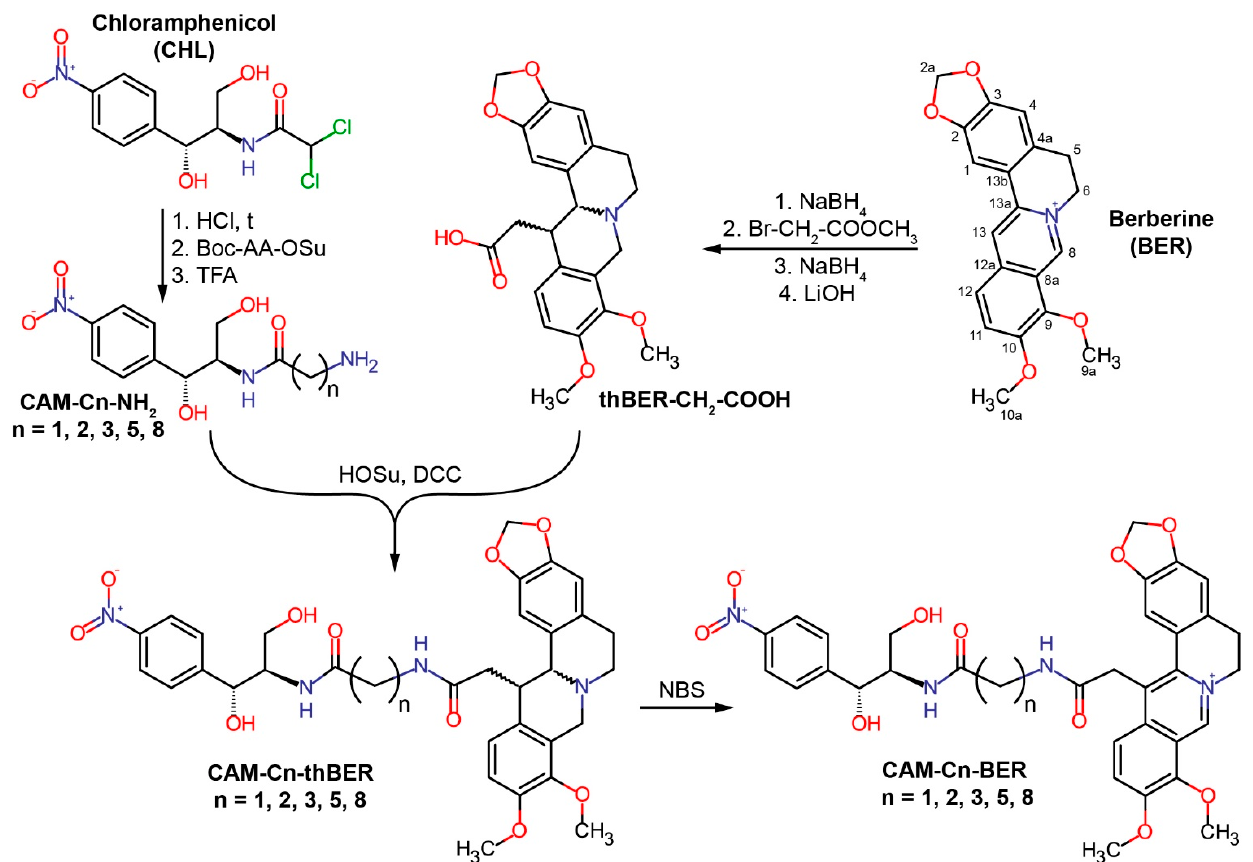
Figure 1. Scheme of the chemical synthesis of conjugates of chloramphenicol amine (CAM) and berberine (BER) containing linkers of different lengths—CAM-Cn-BER, n = 1, 2, 3, 5, 8.